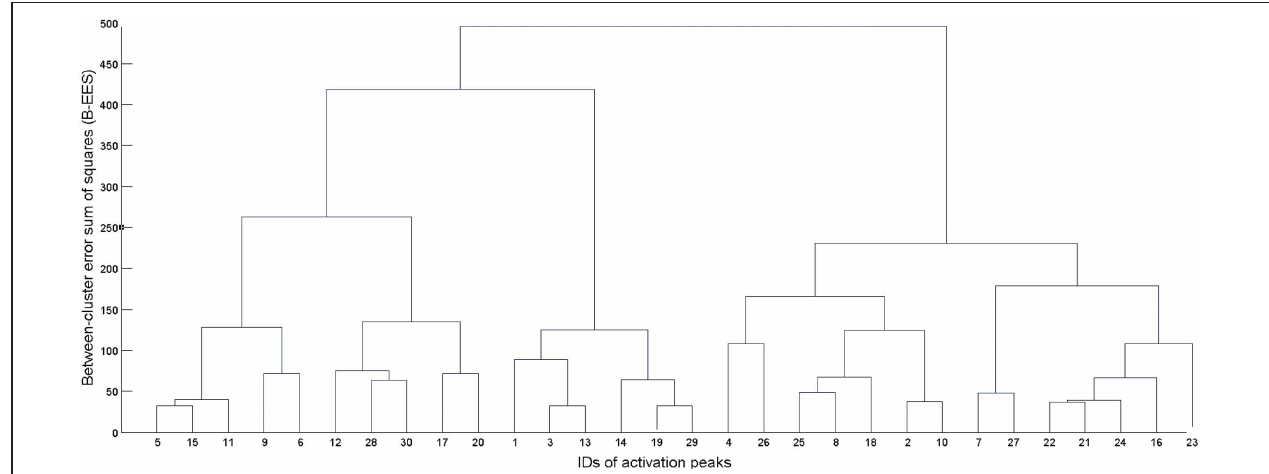
cluster. The number of clusters is thus decreased by one at each level, going from a total of N clusters at step 1 (where N is the number of input activation peaks) to one all-inclusive cluster at the last